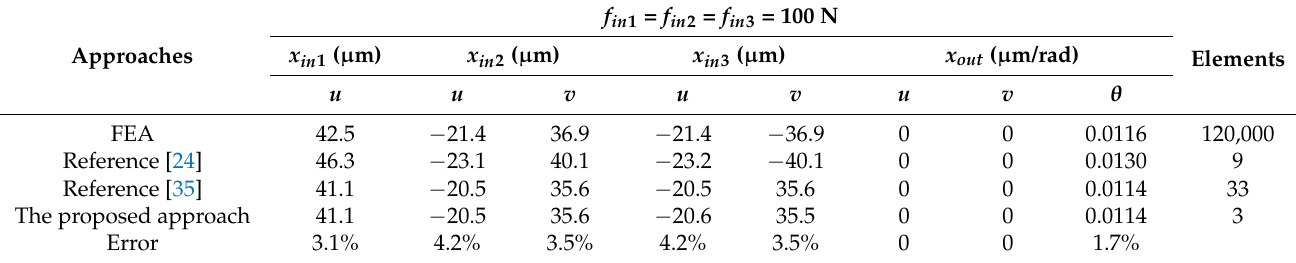
Figure 15. Finite element results. ( a ) f in 1 = f in 2 = f in3 = 100 N; ( b ) f out = [0 N, 50 N, 0 N, 0 N·m, 0 N·m, 1 N·m].